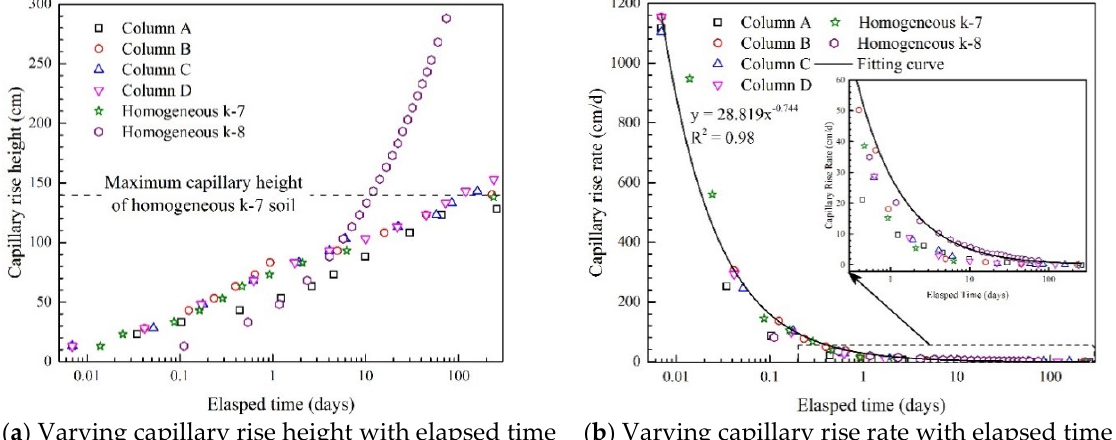
Figure 5. Comparison of the capillary rise height ( a ) and the rate ( b ) between the layered soil profile and the homogeneous soil profile.